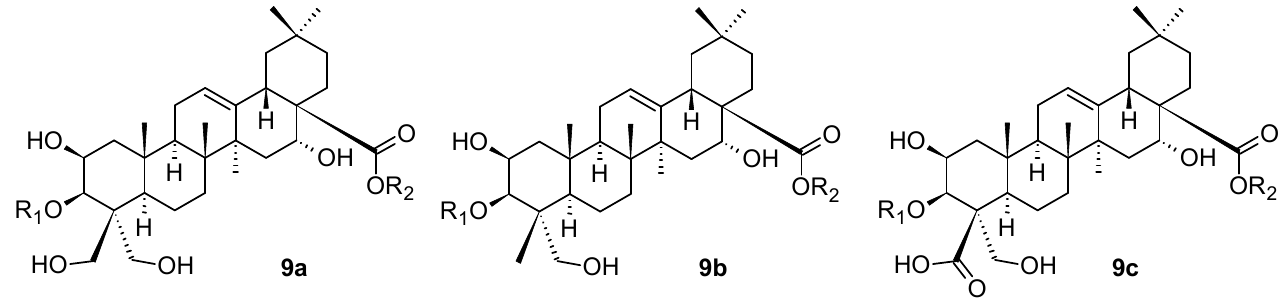
the possible deglycosylation metabolism pathways of platycosides in vivo, and indicated standing the metabolism of platycosides after dietary consumption. Figure 8. Oleanane-type xanthoceraside 8 from Xanthoceras sorbifolium. Figure 8. Oleanane-type xanthoceraside 8 from Xanthoceras sorbifolium .